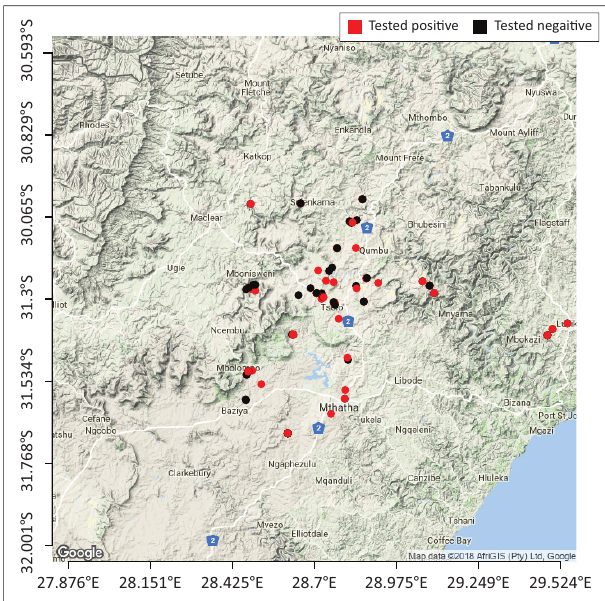
FIGURE 2: Geographic distribution of sampled households with goats (red dots indicate positive test results and black dots indicate negative test